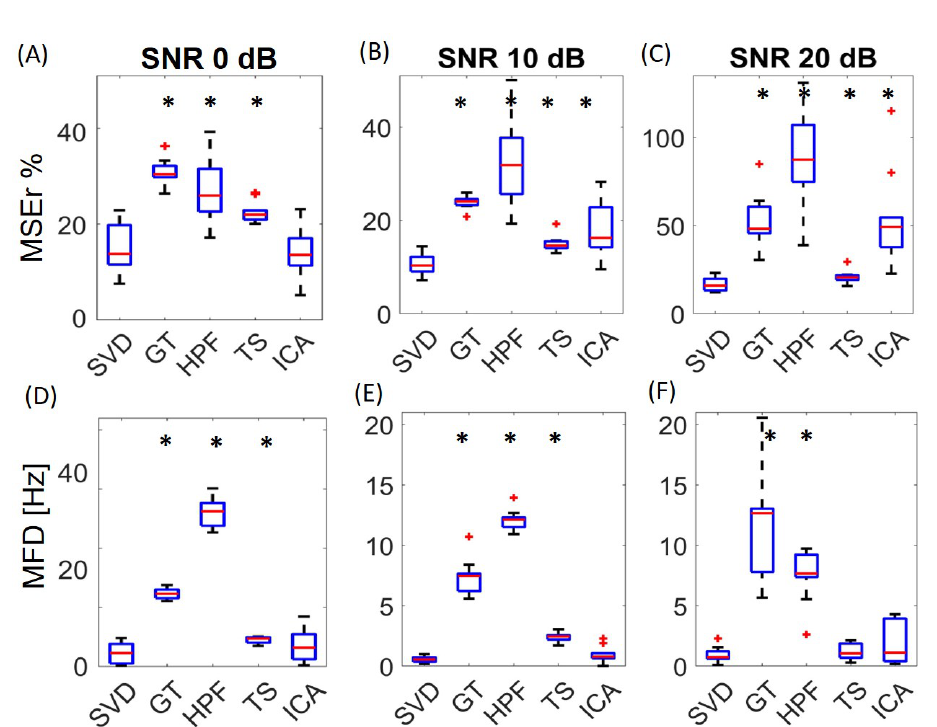
Figure 7. Performance of the different algorithms. SVD: singular value decomposition; GT: gating technique; HPF: high-pass filtering; TS: template subtraction; ICA: independent component analysis. The upper panels show the results in terms of the mean squared error (MSEr) with SNR of 0 dB ( A ), 10 dB ( B ), and 20 dB ( C ). The lower panels show the results in terms of the mean frequency difference (MFD) with an SNR of 0 dB ( D ), 10 dB ( E ), and 20 dB ( F ). * if p -value < 0.05 by the Bonferroni-corrected Wilcoxon